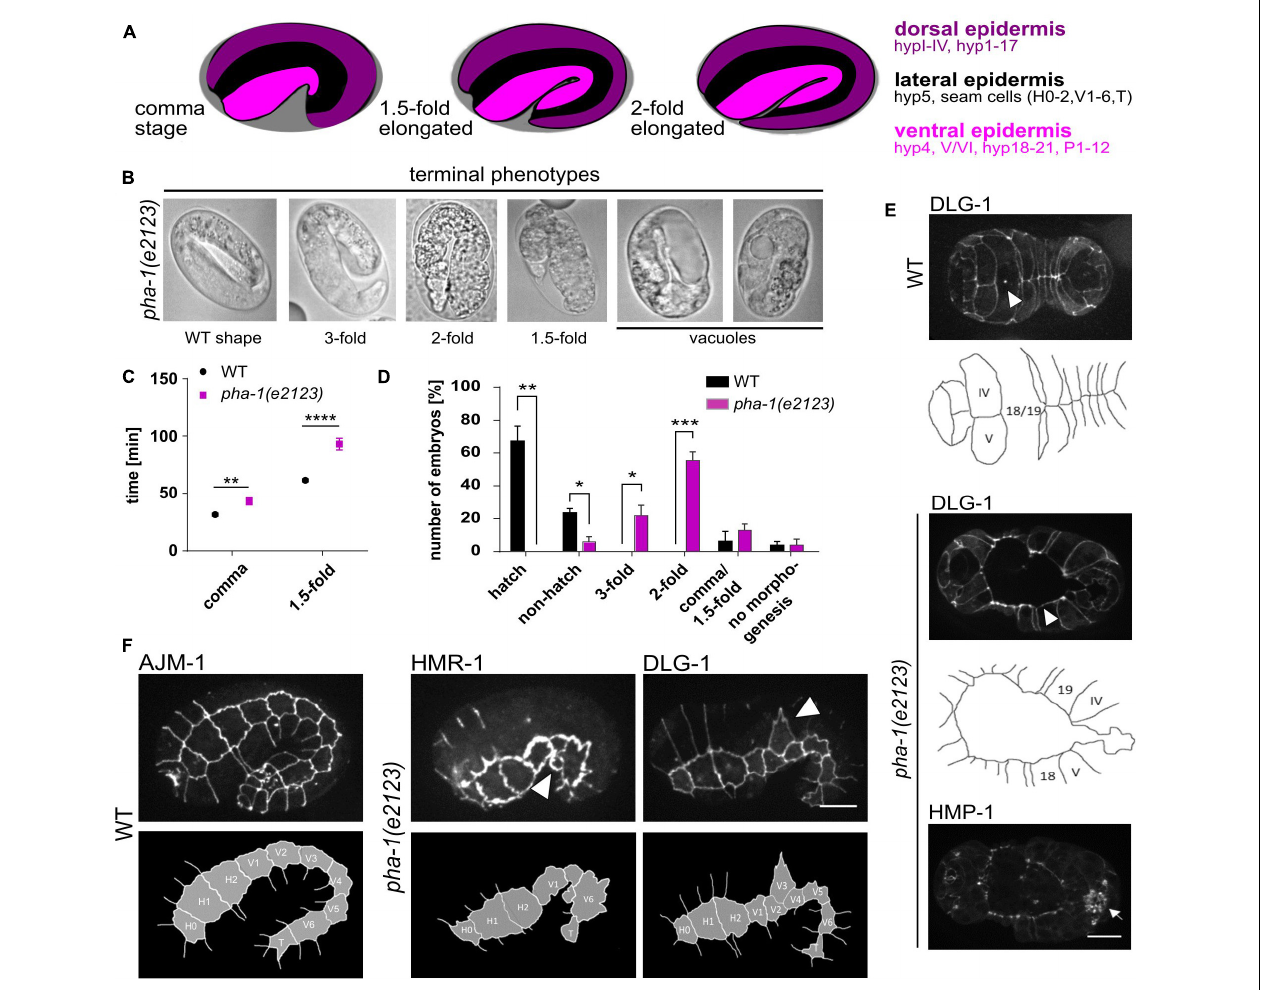
FIGURE 1 | pha-1 mutations affect epidermal morphogenesis. (A) Schematic of C. elegans elongation stages and epidermis organization. (B) Brightfield images of pha-1(e2123) embryos that arrested at different developmental stages (1. 5–, 2–, and 3-fold). (C) Quantification of elongation time (from lima-bean to the 1.5-fold stage) in WT and pha-1(e2123) embryos (with SEM, n = 12/13). (D) Normalized quantification of embryonic arrest in WT and pha-1(e2123) animals mounted with 20 µ m beads (with SEM, n ≥ 90). (E) Maximum projections and corresponding schemes of ventral enclosure in WT and pha-1(e2123) embryos expressing DLG-1::dsRed and HMP-1::GFP. Arrow heads point at cell boundaries of leading cells found at the ventral midline. In pha-1(e2123) embryos ventral enclosure fails in rare cases. Mutant embryos however properly position sensillae (arrow). (F) Maximum projections and corresponding schemes of seam cell localization in WT